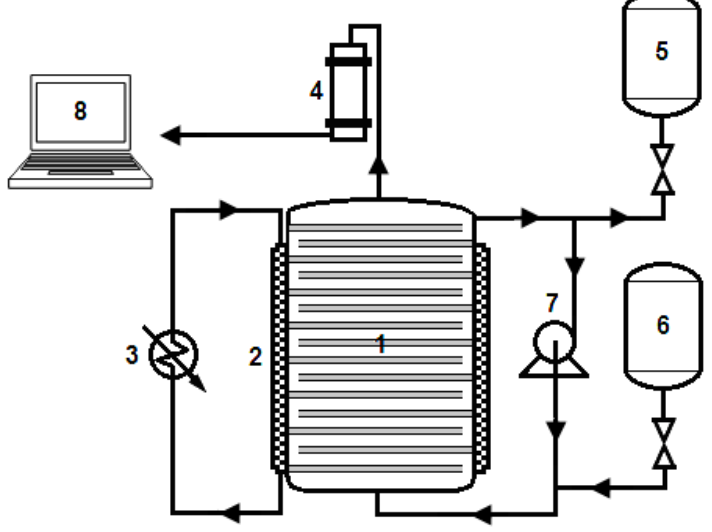
Figure 1. Schematic illustration of the compact multi-layer membrane bioreactor (MMBR). The numbers indicate (1) multi-layer membrane compartment; (2) warm water jacket; (3) water heater; (4) gas flow gauge; (5) digestate wastewater tank; (6) substrate feed tank; (7) peristaltic pump; and (8) control unit